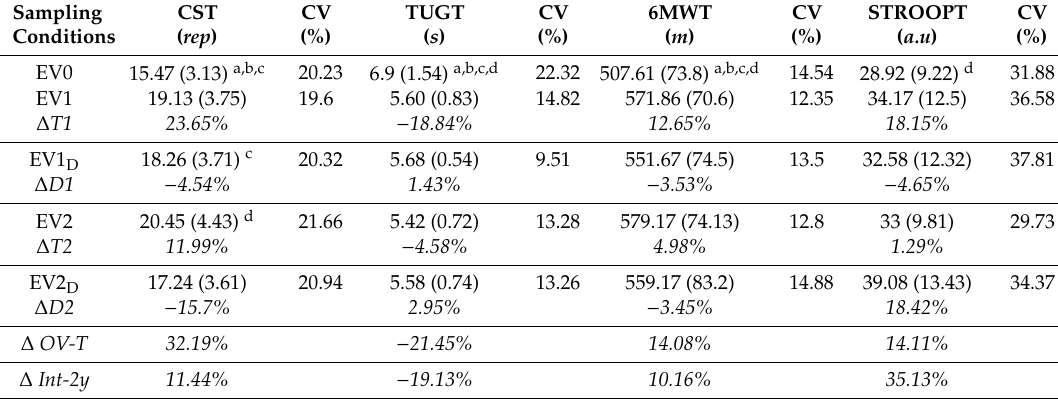
Table 3. Training and detraining changes in physical and cognitive function along two years of EFAM-UV © expressed as mean ( SD